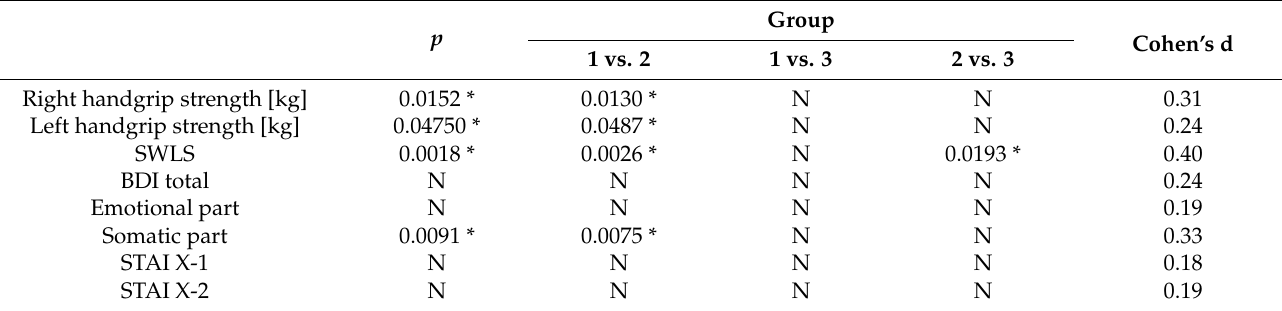
Table 6. Significance of differences in the results between groups (the Kruskal–Wallis one-way ANOVA test and the post hoc test between groups).